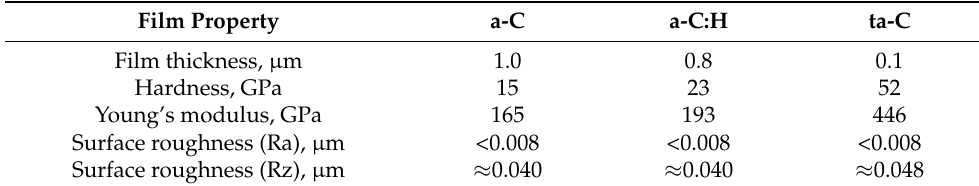
Table 1. Specifications of DLC films (a-C, a-C:H, and